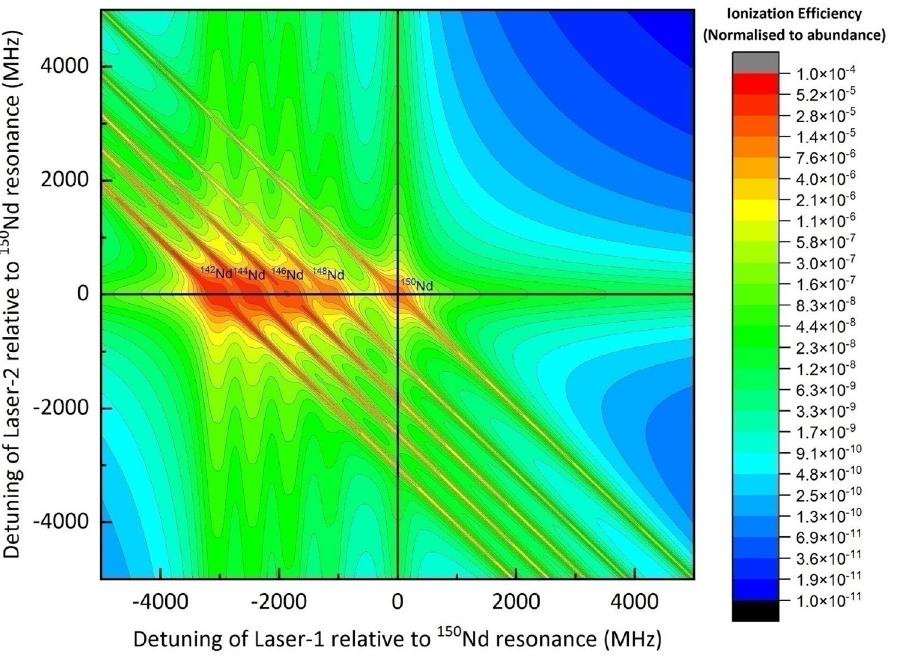
Figure 2. Two-dimensional contour plot of ionization efficiencies of Nd (frequencies relative to the resonance of 150 Nd) for the Doppler-free condition. Bandwidth of all the excitation lasers is set to 100 MHz, and the peak power densities of all excitation lasers are set to 5 W/cm 2